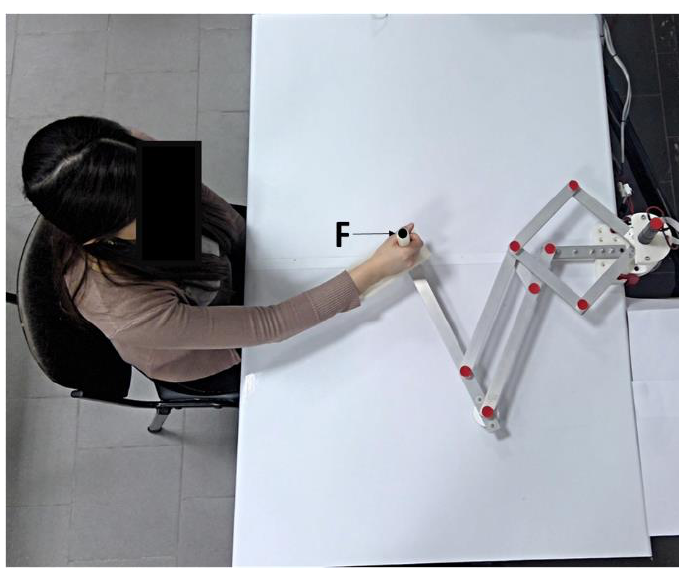
Figure 3. User – mechanism interaction.